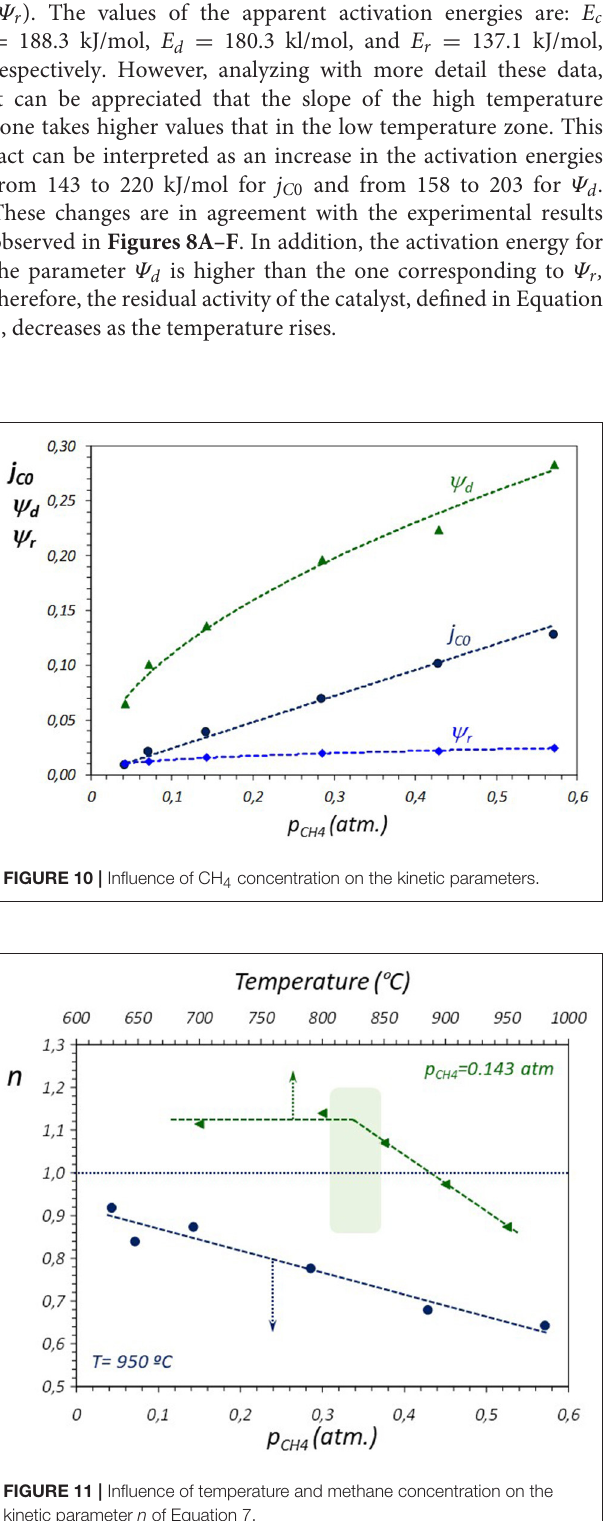
FIGURE 9 | Arrhenius plot of the kinetic parameters. p CH4 = 0.1428 atm.